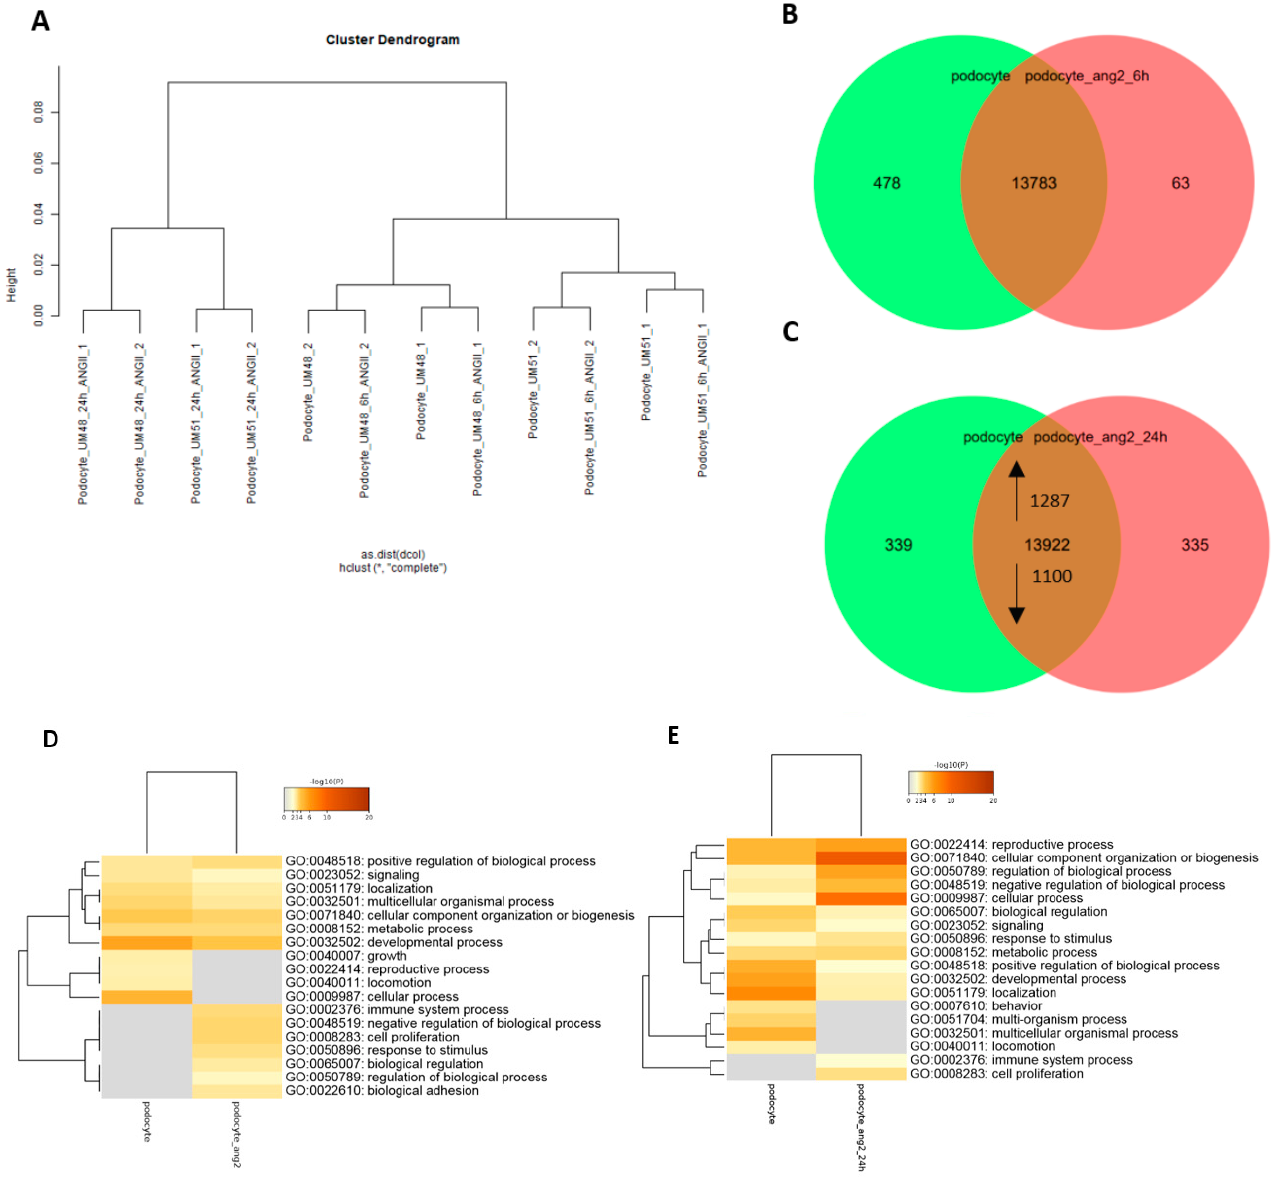
Figure 5. Comparative transcriptome and Gene Ontology analysis of untreated podocytes UM48 and UM51 and treated with angiotensin II for 6 h and 24 h. Podocytes were treated with ANGII (100 µM) for 6 h and 24 h. The hierarchical cluster dendrogram revealed 2 distinct clusters—24 h treated